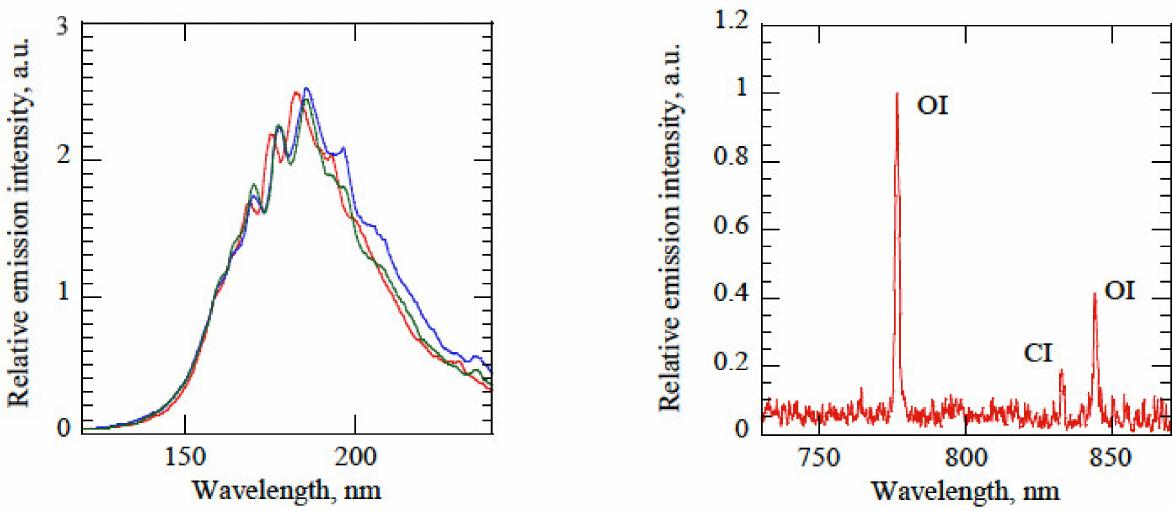
Figure 31. Left: Emission spectrum in VUV for the different runs at 7.1 and 7.3 km/s. Right: Emission spectrum in near region at 7.1 km/s and 200 Pa (from [30]).